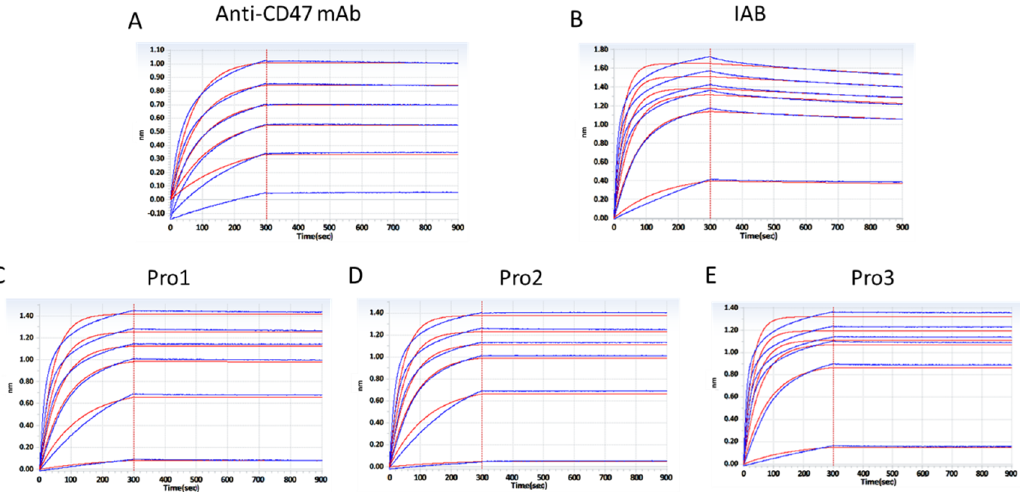
Figure 5. Affinity analysis of proteins to antigen CD47 through a BLI assay. ( A ) The positive control antibody; ( B ) prototype IAB; ( C ) Pro1; ( D ) Pro2; ( E ) Pro3. (Response units vs. time). Table 2. Rate and equilibrium constants of antibodies binding to